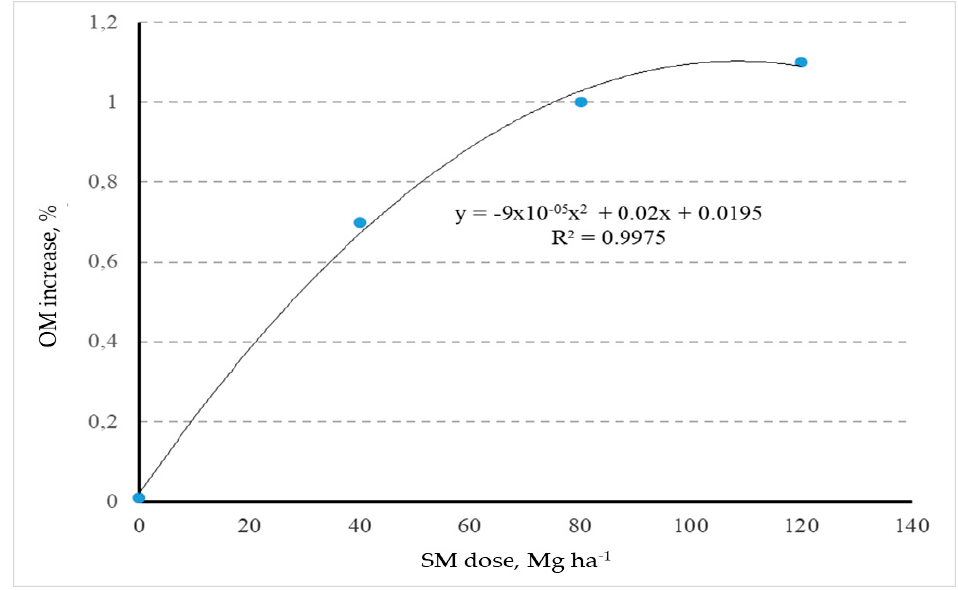
Figure 4. Preliminary quadratic function expressing the e ff ect of SM doses (Mg ha − 1 ) on OM increases (%).